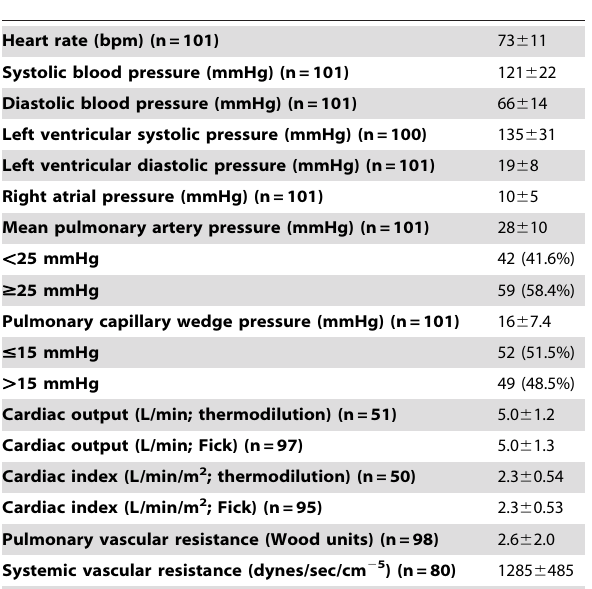
Table 2. Hemodynamic Parameters of the 101 study subjects. Table 3. Echocardiographic